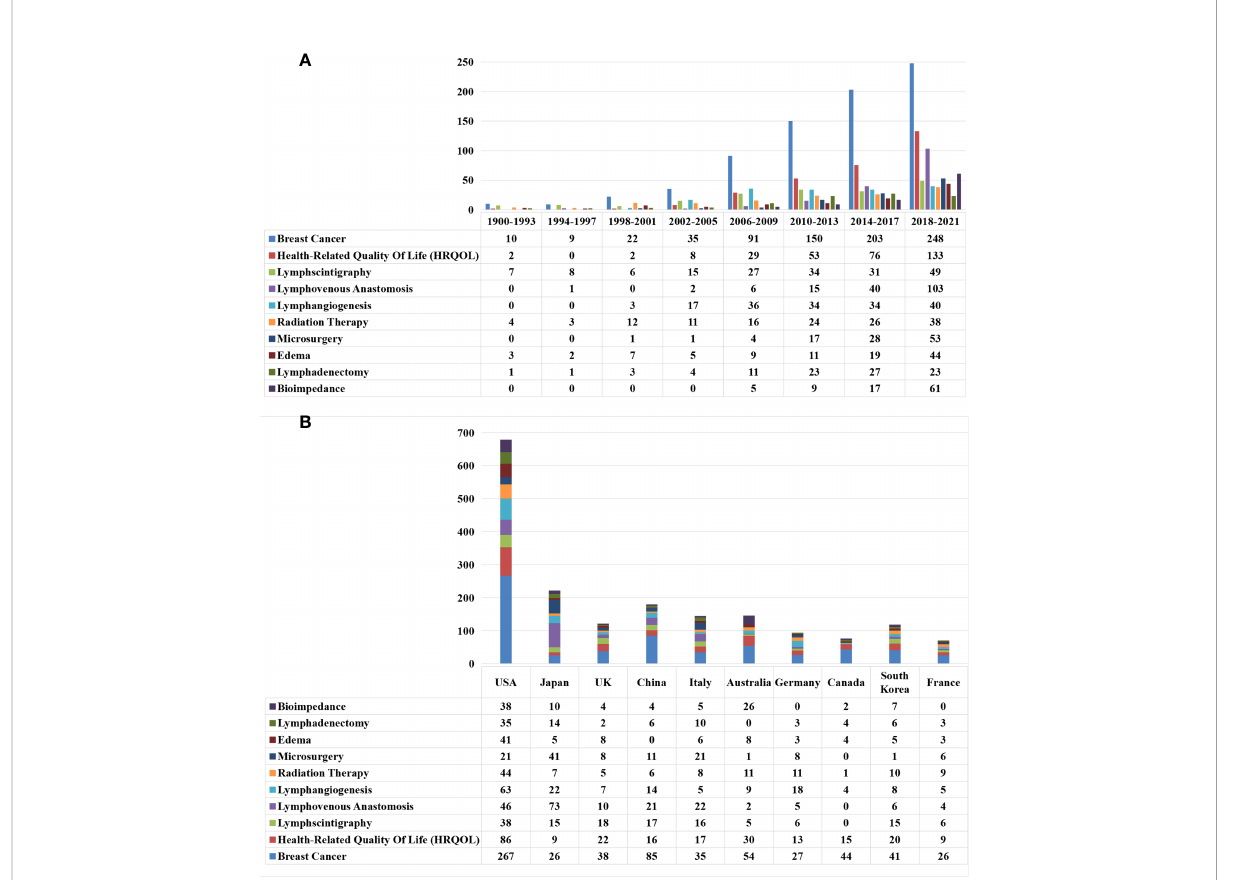
FIGURE 9 The Characteristics of the top-ranked representative keywords in the 5 clustered topics. (A) The annual number of new publications of the top- ranked representative keywords in the 5 clustered topics. between 1900 and 2021. (B) The distribution of the number of top-ranked representative keywords in the 5 clustered topics among the top 10 countries producing lymphedema